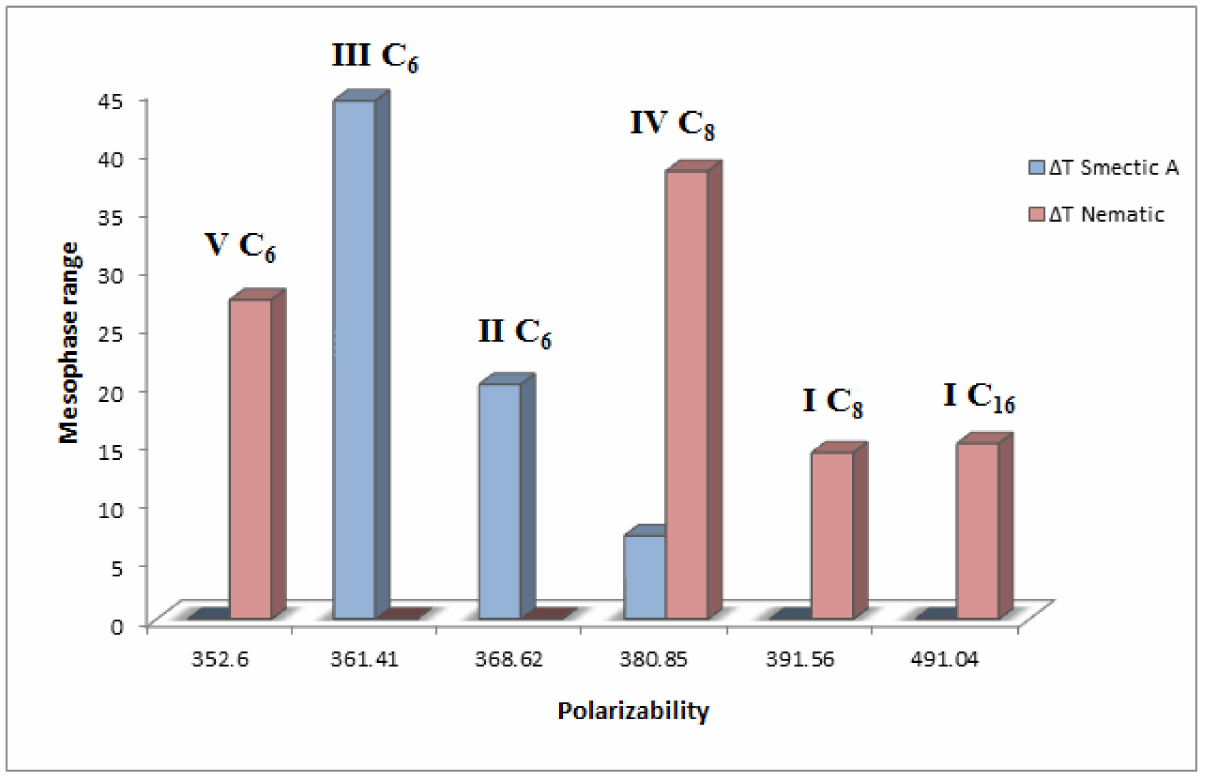
Figure 12. Graph of smectic A and nematic mesophase range versus polarizability of compounds